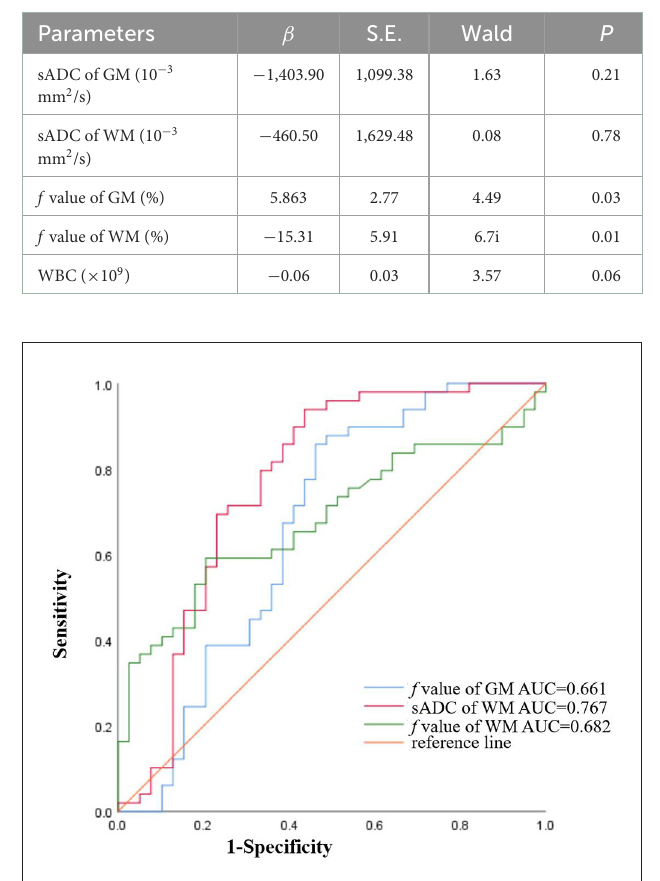
FIGURE3 The ROC curves of sADC of WM (AUC = 0.767), the f value of GM (AUC = 0.661), and the f value of WM (AUC = 0.682) for diagnosing